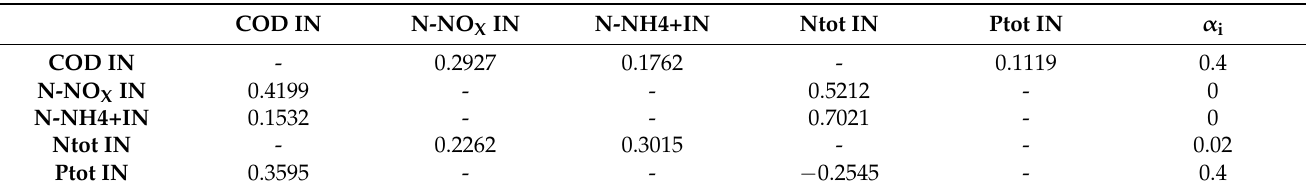
Table 2. Coefficients of multivariate linear regressions of input loads. Rows are indicative of the modeled parameters, while the columns represent coefficients of the model. α i , intercept value with ordinate axis.